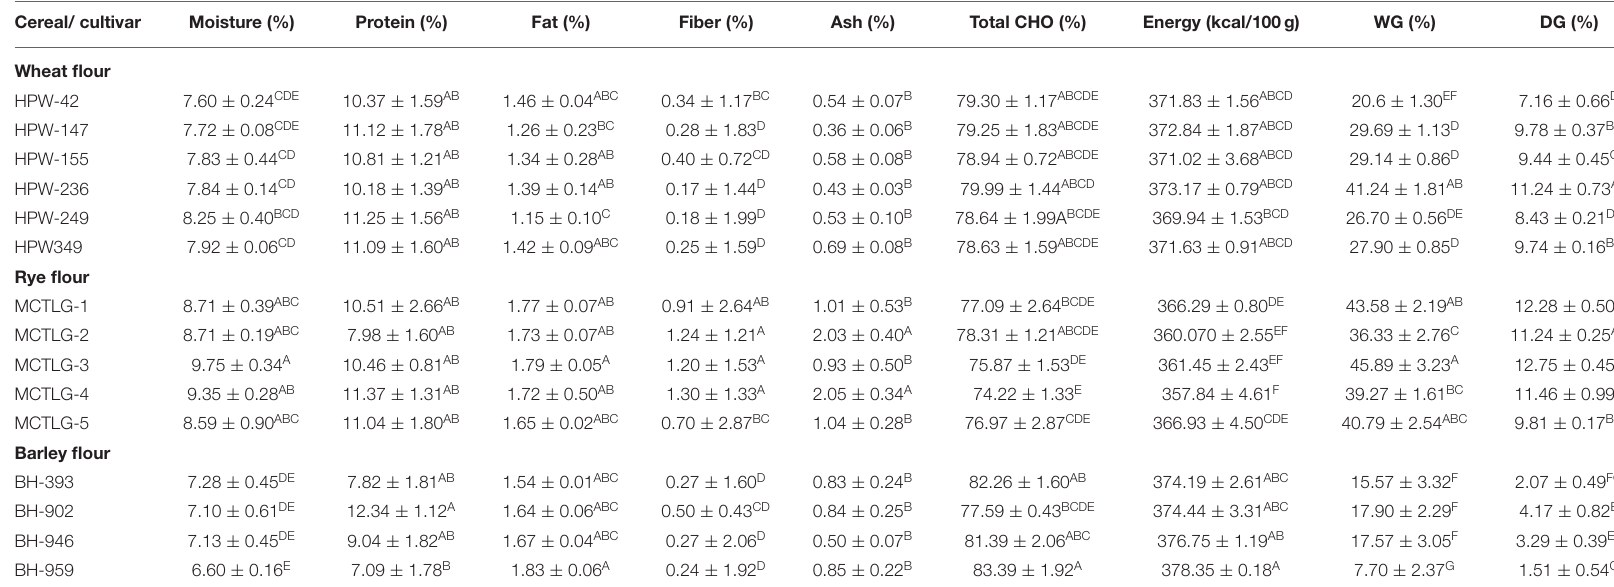
TABLE 3 | Proximate composition and gluten properties of flours of wheat, rye, and barley cultivars. Cereal/